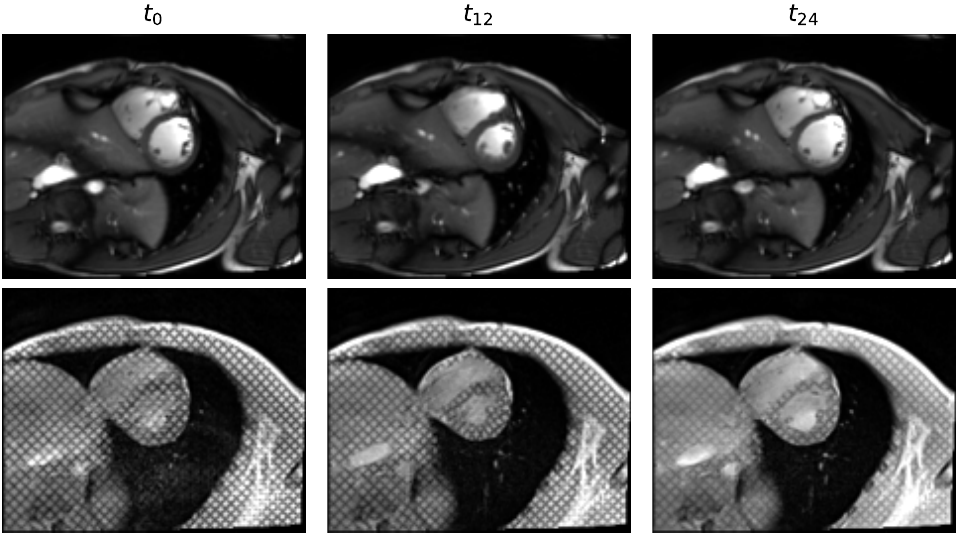
Figure 2. Example of SAX cine and associated tagged cardiac MR images through time from a control patient. Times { 0,12,24 } are displayed from recordings of 25